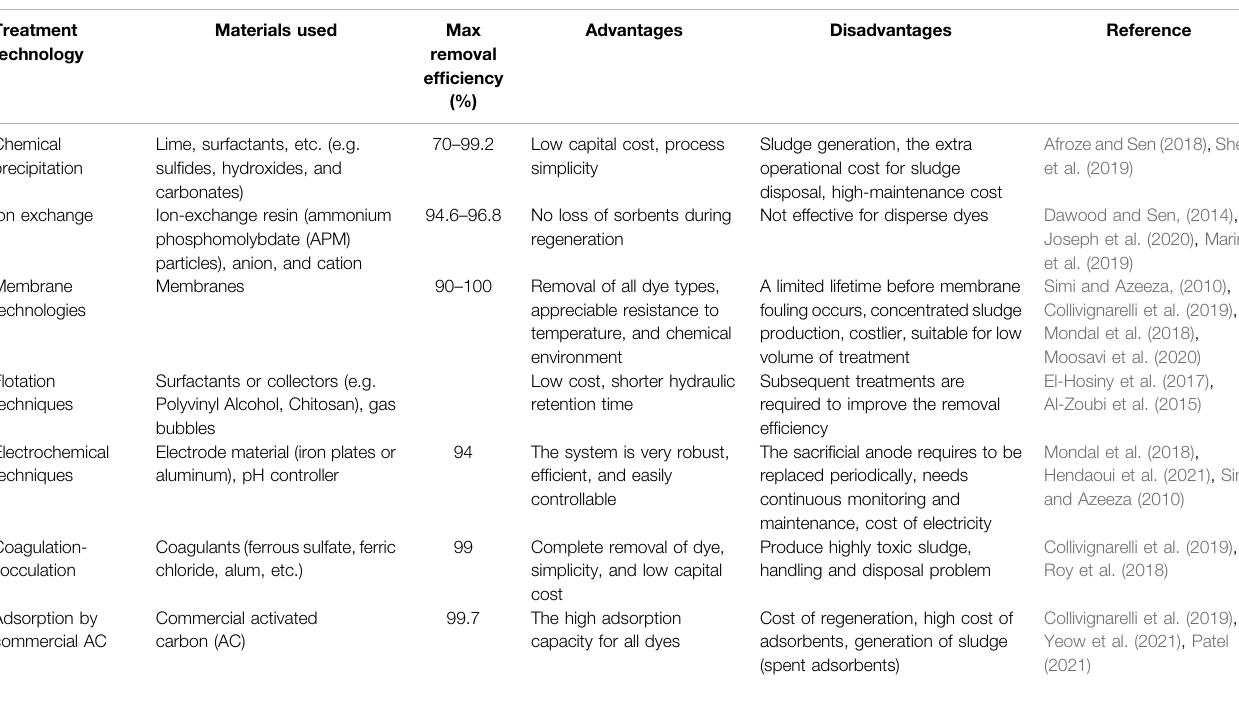
TABLE 1 | Advantage and disadvantages of the dye removal process technologies.